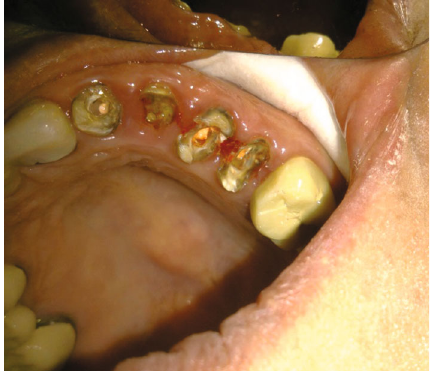
Figure 2: Occlusal and palatal view of central, lateral, canine, and premolars.